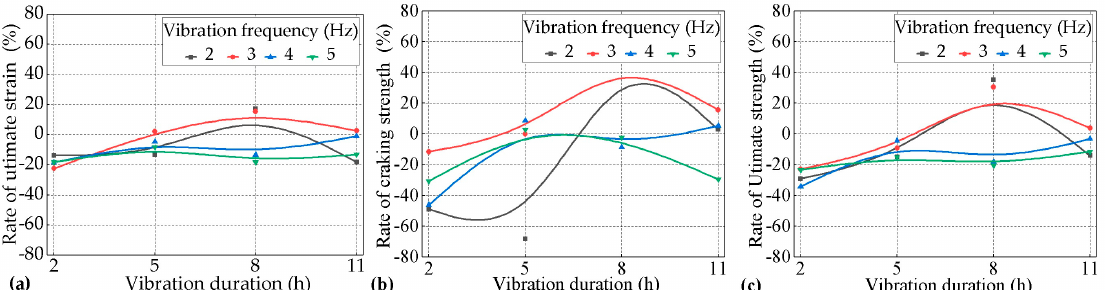
Figure 7. Rates of ( a ) the ultimate tensile strain, ( b ) cracking strength, and ( c ) ultimate tensile strength for the vibrated groups over the control group with the increase of the length of vibration duration under di ff erent levels of vibration frequency during the period between the initial set and the final set.